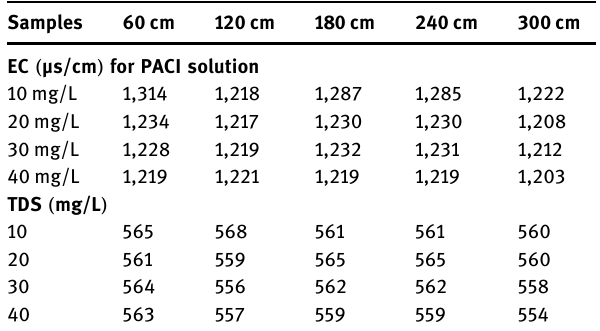
Figure 11: The relation between pH and dosages of coagulant and its aids for samples at a height of 240 cm.